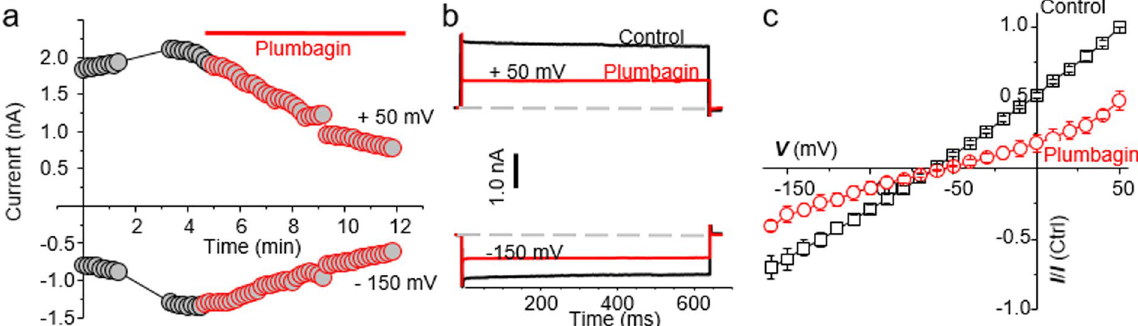
Figure 4. Plumbagin inhibits NKA channel currents. ( a) The time course measurement of current amplitude in a representative CTAC cell before and after plumbagin (5 μ M) treatment. For these recordings, current was measured at + 50 mV (as outward current) and − 150 mV (as inward current) from a holding potential of − 60 mV. ( b) Representative current trace during control (black traces) and plumbagin ( 5 µ M) treated (red traces) CTAC cell is shown at either + 50 mV or − 150 mV from a holding potential of − 60 mV. Dotted lines represent